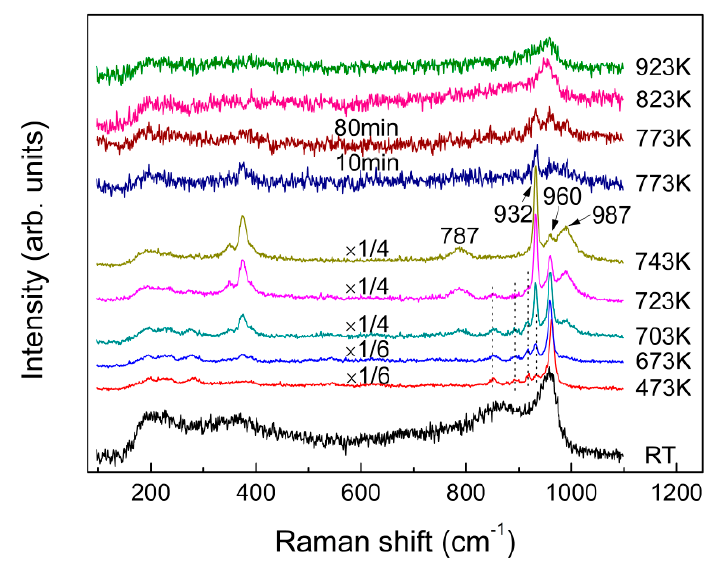
Figure 7. In-situ Raman spectra of the as-quenched (fast quenched) KAl(MoO 4 ) 2 sample recorded from RT to 923 K.